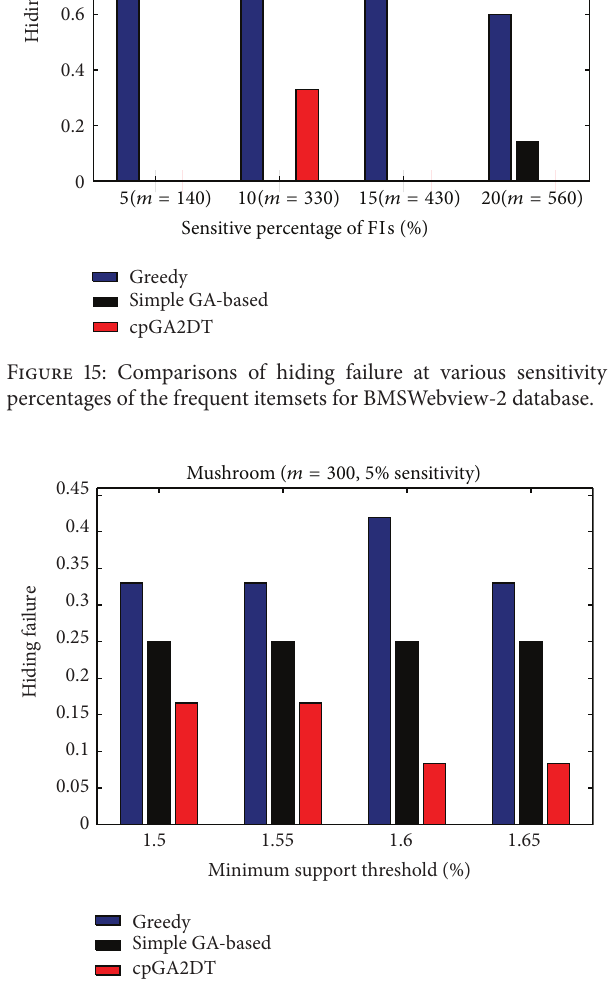
Figure 16: Comparisons of hiding failure at various minimum support thresholds for mushroom